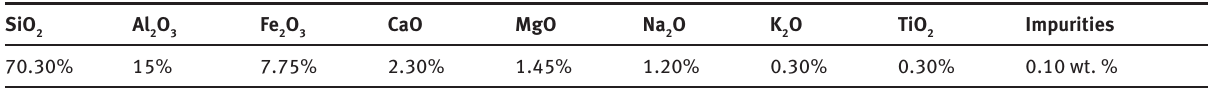
Table 2: The chemical composition of